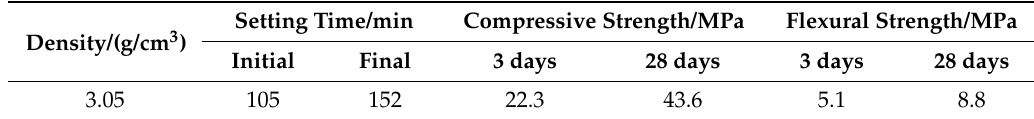
Table 2. Properties of the cement.